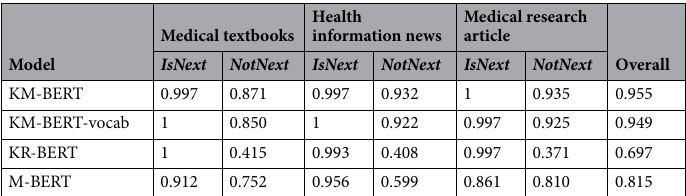
Table 2. NSP accuracy of the intrinsic evaluation dataset.